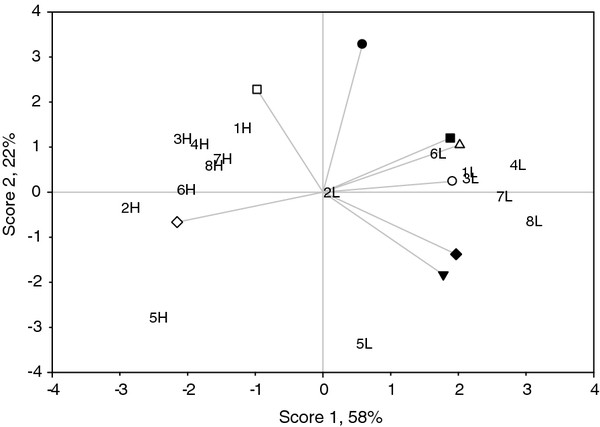
Principal component analysis (a biplot of antibacterial data of CFS produced by 8 selected bacteriocinogenic LAB cultured at 5 and 20°C). Indicator organisms included: Leuc. mesenteroides CFS, untreated (●), Leuc. mesenteroides CFS, pH neutralized (○), B. cereus CFS, untreated (▼), L. innocua CFS, untreated (Δ), L. innocua CFS, pH neutralized (■), L. innocua CFS, pH neutralized and H2O2 eliminated (□), Erw. carotovora CFS, untreated (♦), and Ps. fluorescens CFS, untreated (◊). H-20°C; L-5°C; 1-Arla-18 (Ent. faecium); 2-ASR-1 (Strep. thermophilus); 3-ASR-6 (Ent. faecium); 4-JFR-1 (Ent. faecium); 5-JFR-5 (Lact. casei); 6-TSB-8 (Strep. thermophilus); 7-OKA-14 (Ent. faecium); 8-Yog-3S (Ent. faecium).